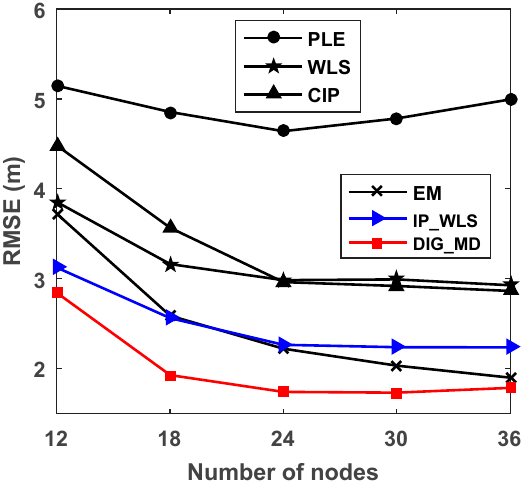
Figure 8. RMSE of PLE, WLS, CIP, EM, IP_WLS and DIG_MD vs. the number of nodes when σ 1 = 2 ◦ , σ 2 = 15 ◦ .